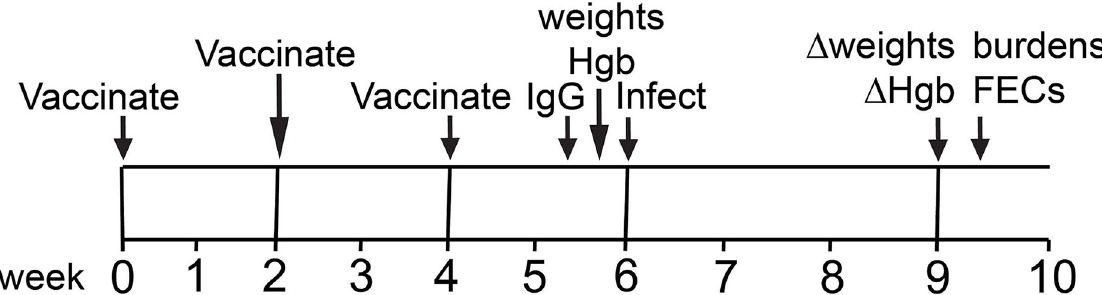
Fig 2. Vaccine trial timeline. Abbreviations—IgG: serum immunoglobulin G titers determined by ELISA; Hgb: blood hemoglobin concentration determined; weights: hamsters weighed; Δ weights, change in weights after hookworm infection calculated after second weight taken; Δ Hgb, change in blood hemoglobin concentrations after hookworm infection calculated after second hemoglobin measurement taken; FECs, overnight fecal egg counts determined.